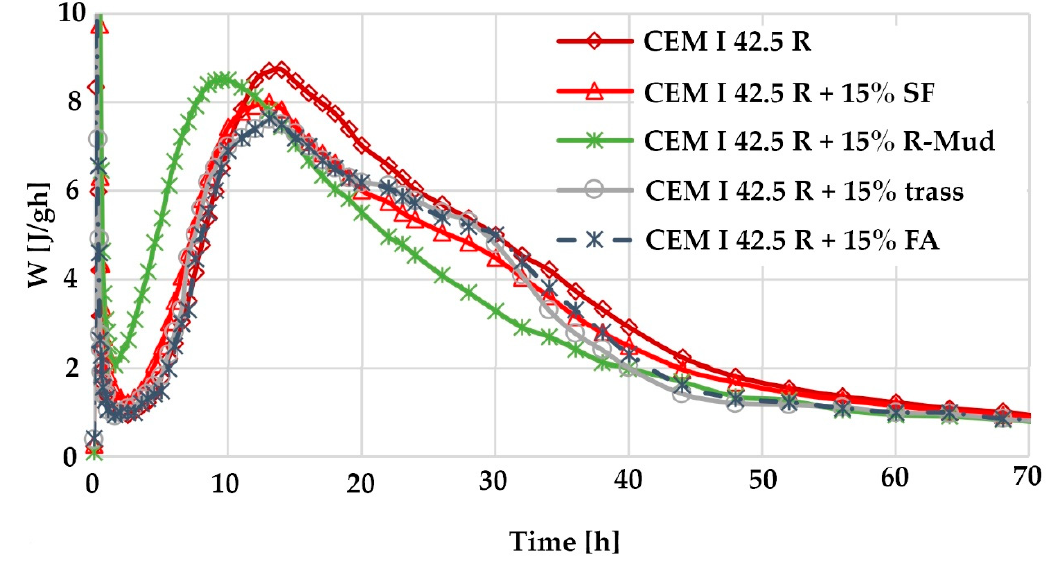
Figure 10. Rate of heat development during hydration of cement of tested mixtures of cement and individual pozzolana at a temperature of 20 °C at w/s = 0.5 − W = dQ/dt (J/g h).